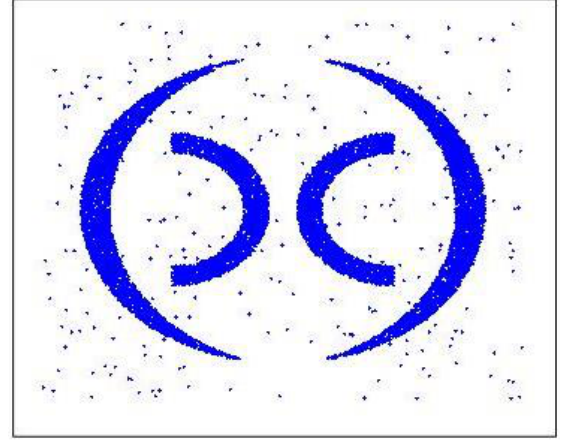
Figure 8. Original distribution of experimental data set 1.